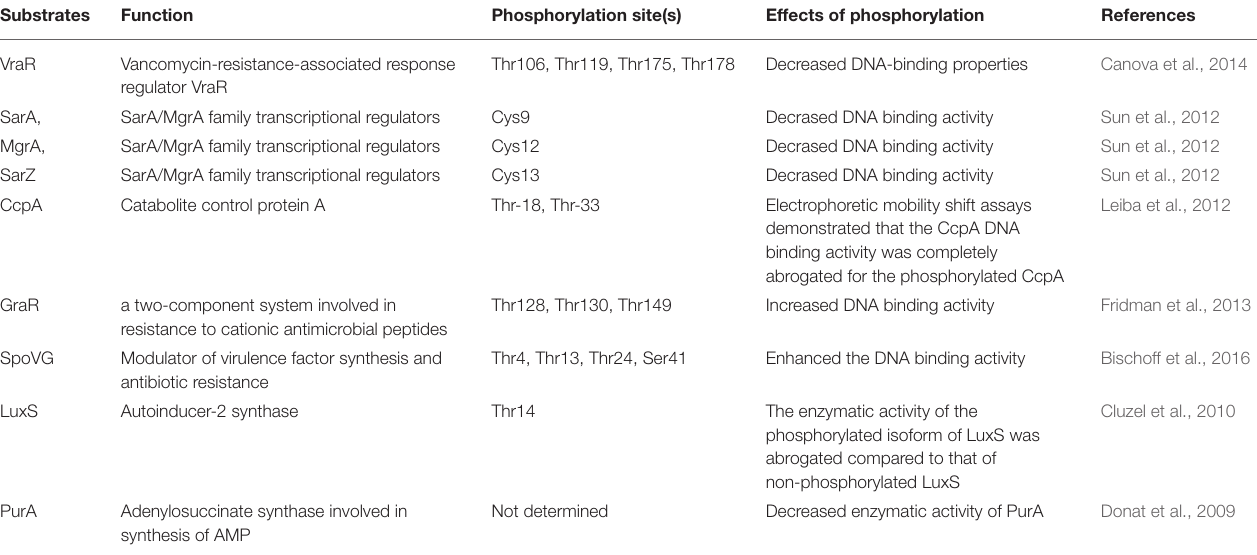
TABLE 3 | Summary of substrates of Stk1/Stp1 determined in S. aureus .